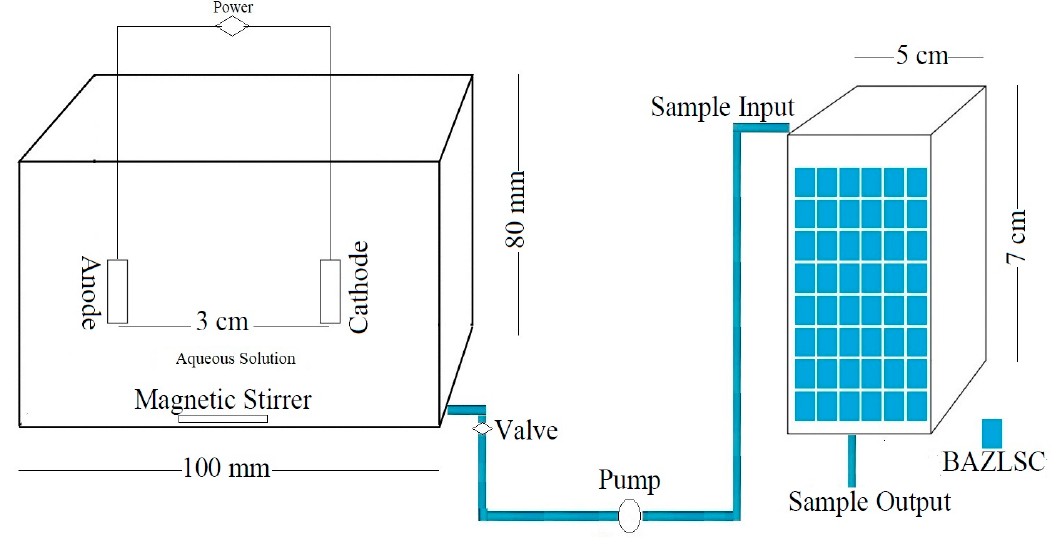
Figure 1. Schematic diagram of the EO reactor ( left ) and adsorption column ( right ) used in this study.